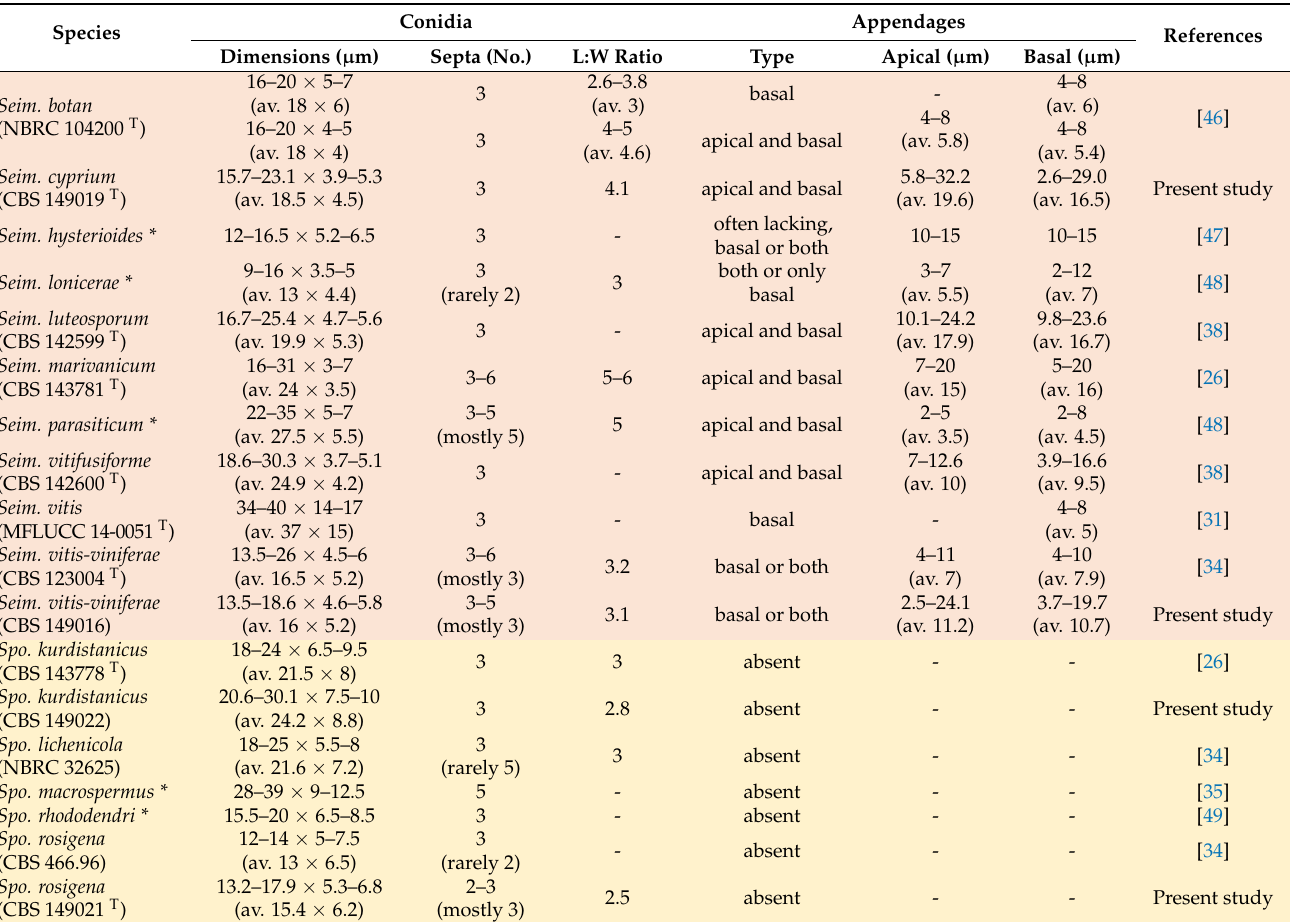
Table 2. Conidial features of Seimatosporium and Sporocadus species reported on Vitis vinifera a . Conidia Species